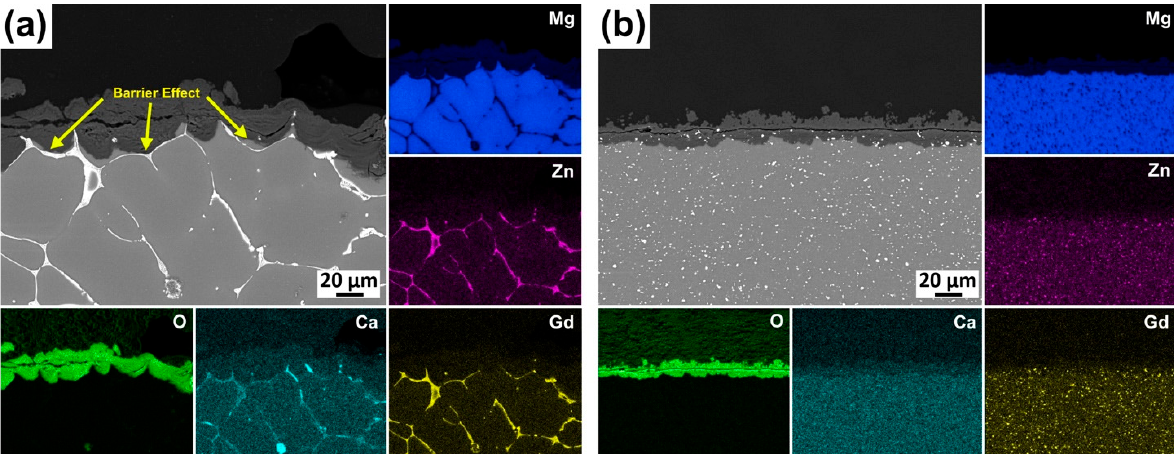
Figure 13. Cross-section SEM micrographs after 48 h of immersion in 3.5% NaCl with the associated EDS map of the elements in ( a ) the as-cast alloy and ( b ) the alloy extruded at 350 °C.